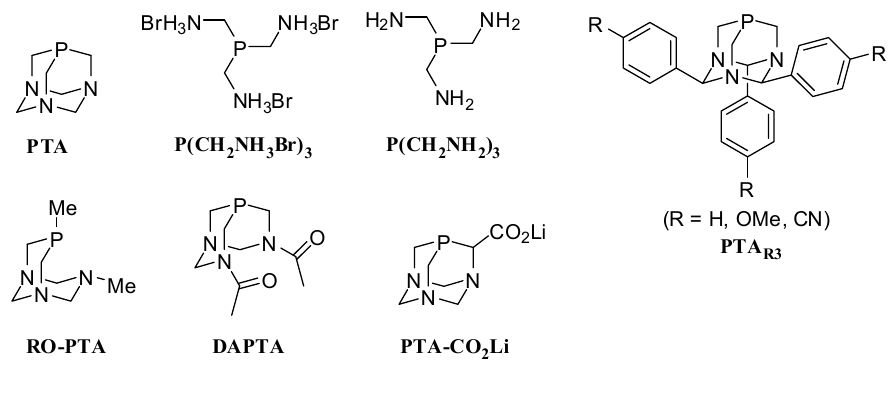
Figure 1. PTA and derivatives of